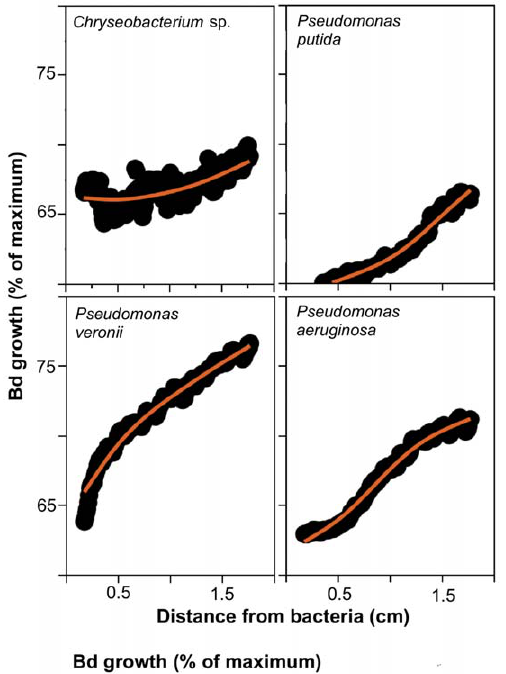
Figure 3. Representative examples of Bd growth at varying distances from putatively inhibitory bacteria. Lines denote spline regression models (Lambda =1.0) with R 2 values of 0.62 ( Chryseobac- terium sp.) and above 0.95 (all the other ones).